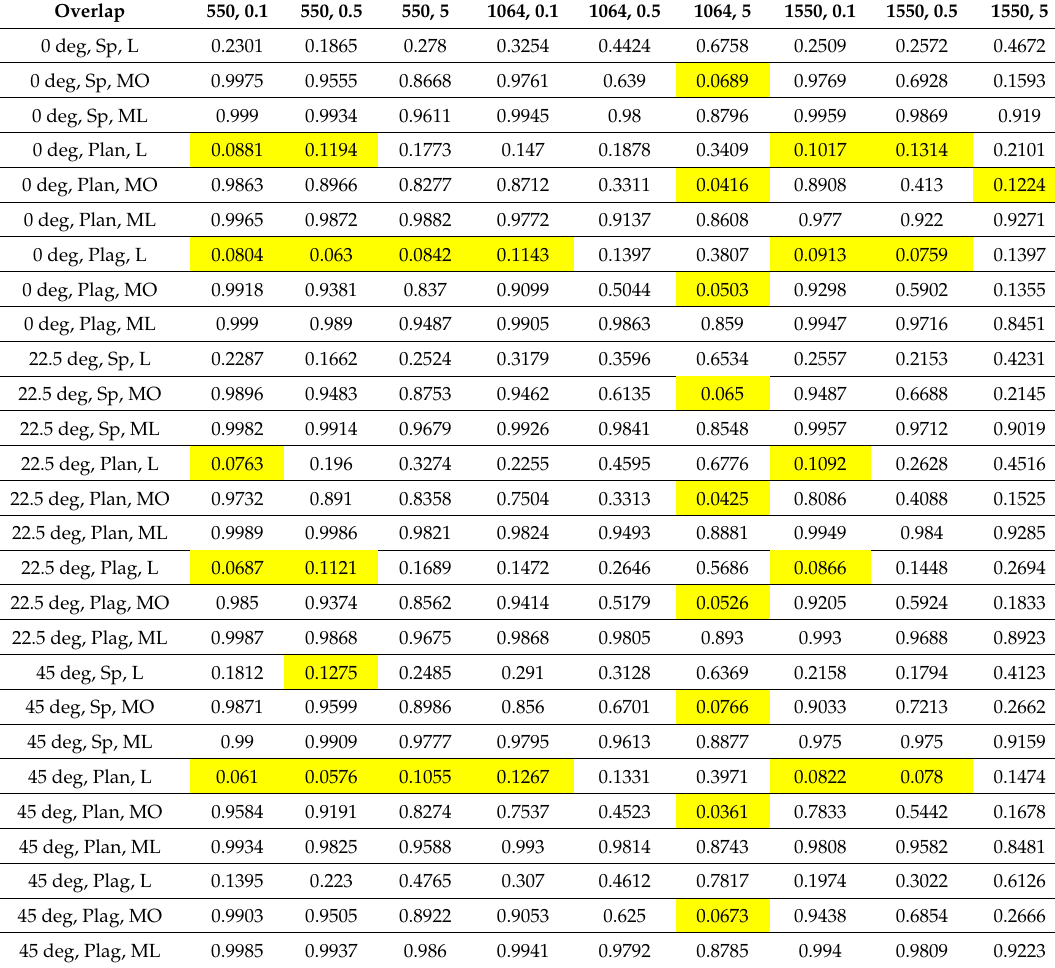
Table A2. Overlap statistic for each configuration. The shorthand for the descriptions for the columns are wavelength in nm and footprint in m, while the rows are zenith view angle in degrees, LAD type (Sp–spherical, Plan–planophile, Plag–plagiophile), and leaf BSDF (L–Lambertian, MO–model reflectance non-transmitting, ML–model reflectance Lambertian transmittance). Yellow highlights are the top 10% of the data